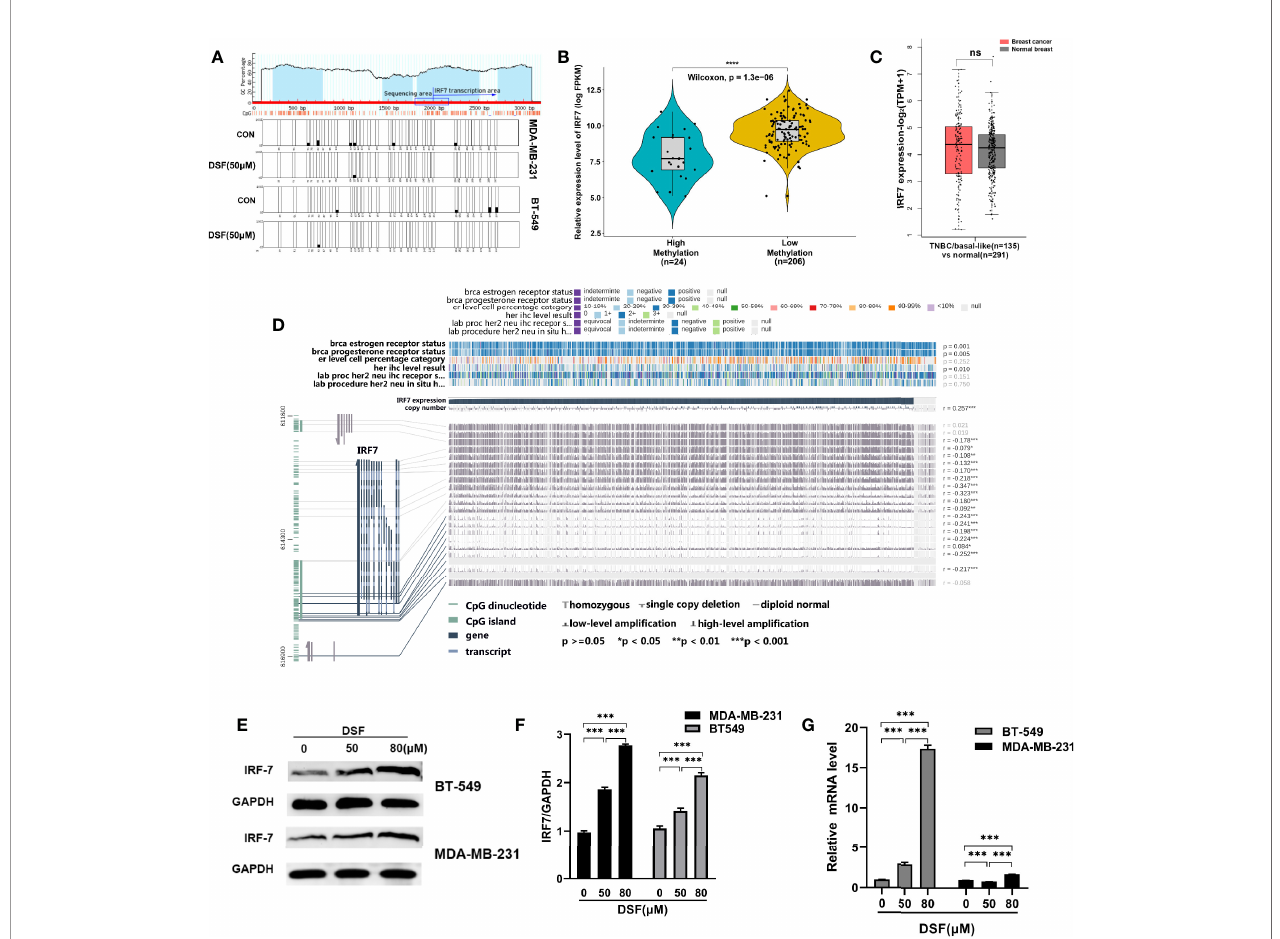
FIGURE 2 | DSF upregulates IRF7 by hypomethylating IRF7. (A) The hypomethylation status of IRF7 promoter regions assessed by bisul fi te sequencing analysis in the human MDA-MB-231 cells and BT-549 cells treated with DSF (50 m M) for 48 h. (B) The negative relationship between the mRNA expression of IRF7 and the methylation level of IRF7. The samples in TCGA are divided into high methylation groups (green, n=24) and low methylation groups (yellow, n= 206). (C) Gene expression analysis of IRF7 using GEPIA2 database based on the TCGA and GTEx database. Box plots represent the gene expression level in terms of log2 (TPM+1) in the tumor (TNBC/ basal-like subtype, red, n=135) and normal breast tissue (gray, n=291) samples, respectively. (D) Visualization of TCGA data for IRF7 expression in 1,217 patients using MEXPRESS. The samples are ordered by their expression value. This view shows the relationship between IRF7 expression and methylation around CpG island and promoter region, clinical features, as well as CNVs. Statistical signi fi cance was indicated in the right side. (E) IRF7 expression in human BT-549 and MDA-MB-231 cells by Western blotting after treatment with different doses of DSF for 48 h. (F) Quantitative analysis of IRF7 expression after different doses of DSF for 48 h through ImageJ intensity measurements. (G) The relative mRNA expression levels of IRF7 in human MDA-MB-231 cells and BT-549 cells treated with indicated concentration of DSF for 48 h. ***p < 0.001, ****p < 0.0001. ns, no statistic signi fi